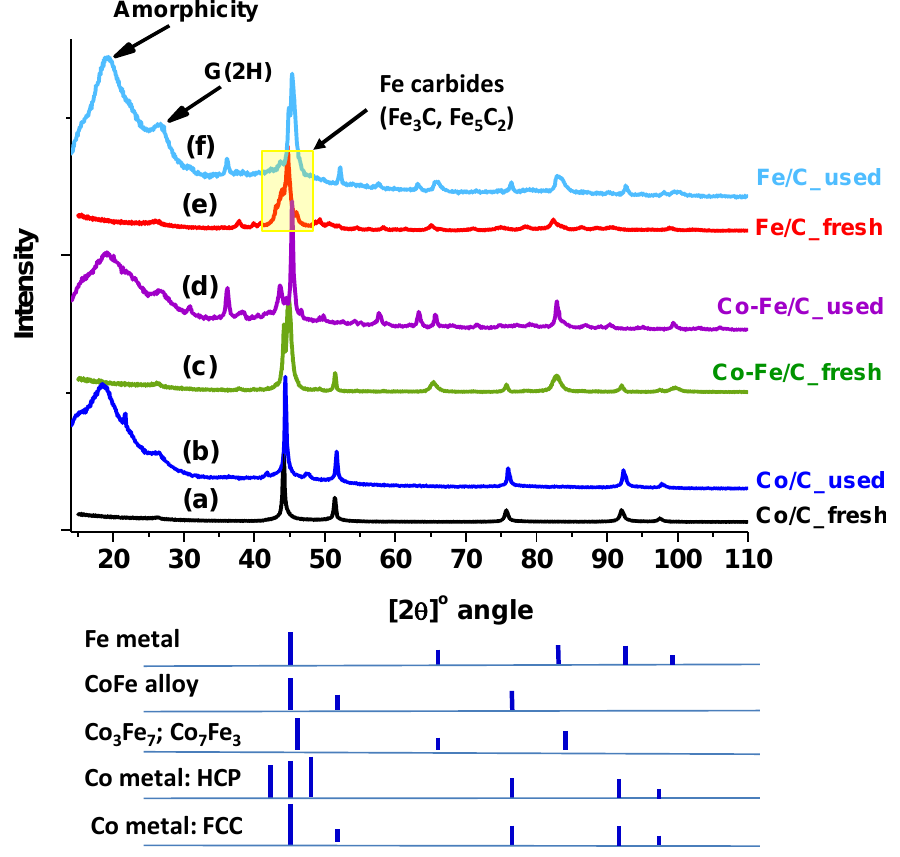
Figure 18. The XRD patterns of the catalyst samples for ( a ) fresh Co/C ( b ) used Co/C ( c ) fresh Co-Fe/C, ( d ) used Co-Fe/C ( e ) fresh Fe/C and ( f ) used Fe/C.